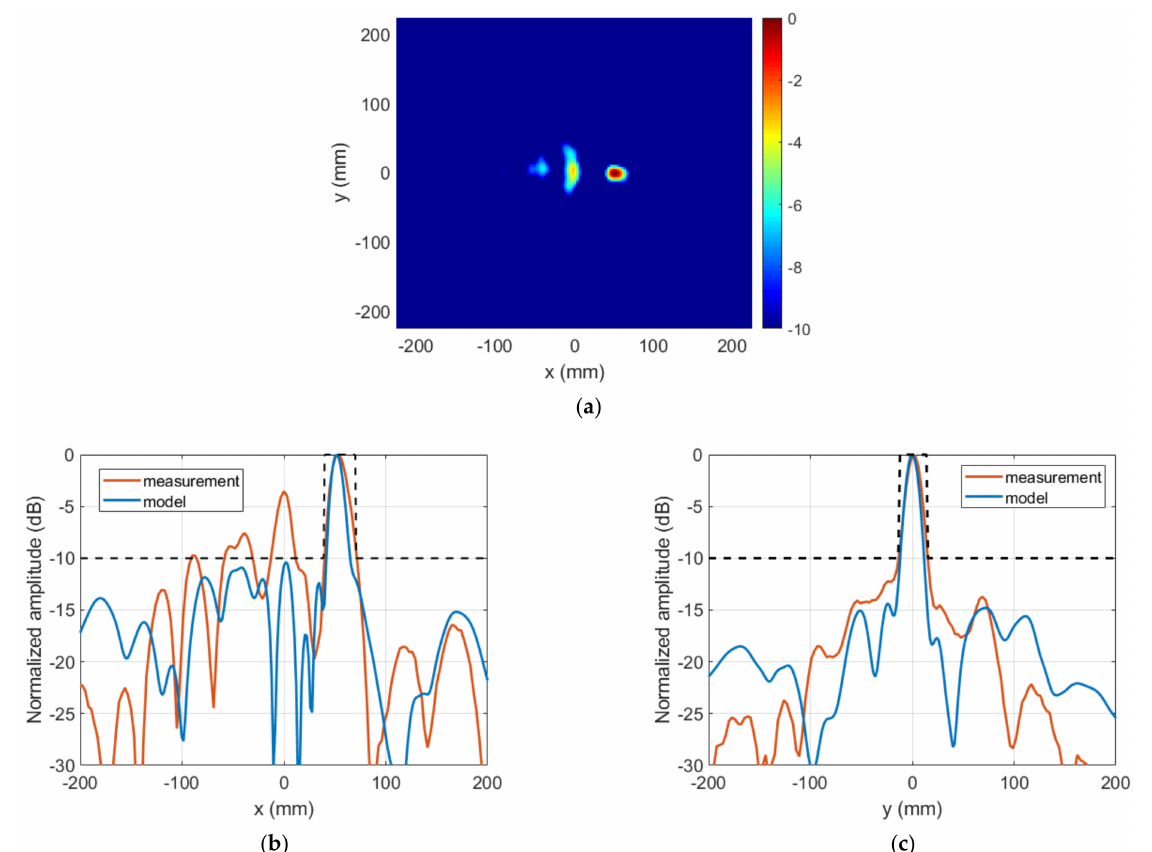
Figure 18. Case 2, NF results of the prototype. NF amplitude at z = 0.6 D : ( a ) measurement (normalized amplitude, dB); ( b , c ) comparison of model result and measurement.